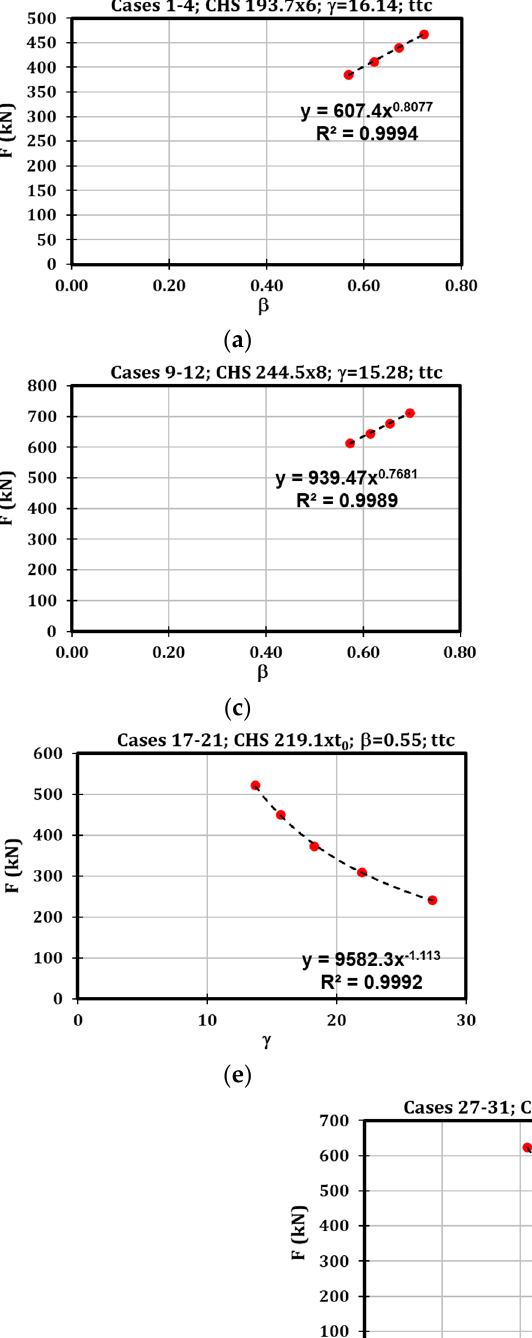
(cid:0) (cid:1) b 1 t 0 f y versus β and